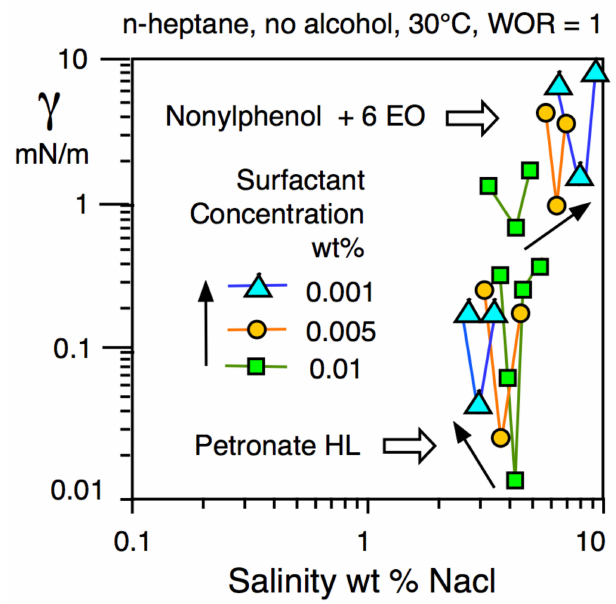
Figure 21. Variation of optimum salinity versus surfactant concentration for ionic and nonionic